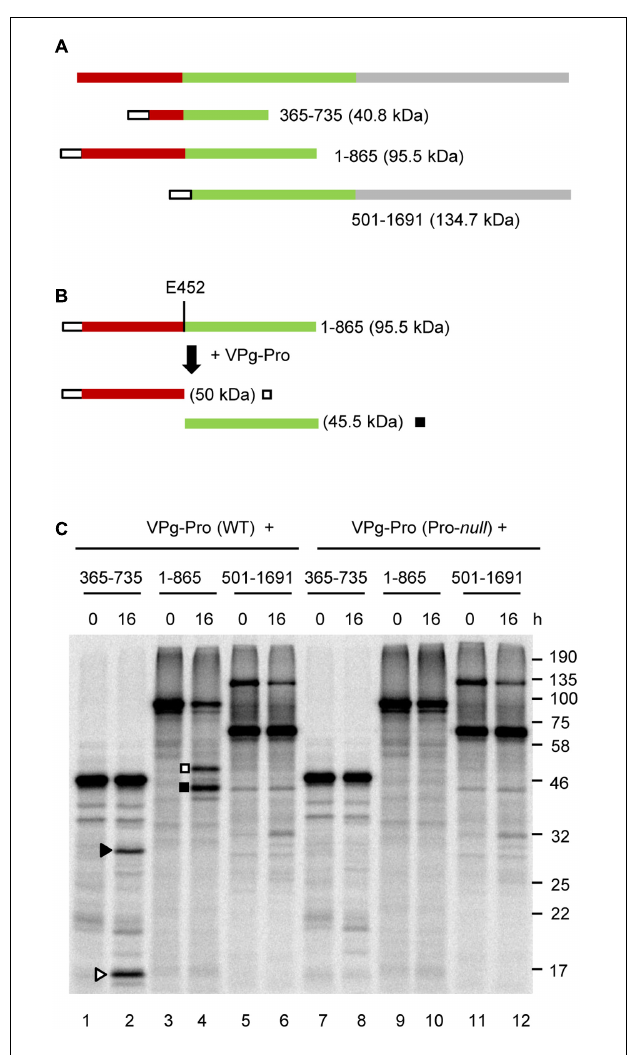
FIGURE 5 | In vitro trans -processing assays of larger partial P2 polyprotein precursor clones confirm that the RNA1-encoded protease recognizes only the MP-CP cleavage site. (A) A schematic representation of overlapping partial P2 precursor polyproteins is shown. (B) Schematic representation of the 1-865 precursor and the detected cleavage products is shown. (C) In vitro processing reactions of the P2 polyprotein precursor clones were incubated with unlabelled VPg-Pro (wild-type or Pro- null mutant derivative) overnight at 16 ◦ C followed by separation of the polyprotein precursor and potential cleavage products by 12% SDS-PAGE. Cleavage products are represented by symbols on the right side of each lane as shown in the schematic representations ( B for precursor 1-865 and Figure 4B for precursor 365-735). The migration positions of molecular mass markers (kDa) are indicated on the right of the